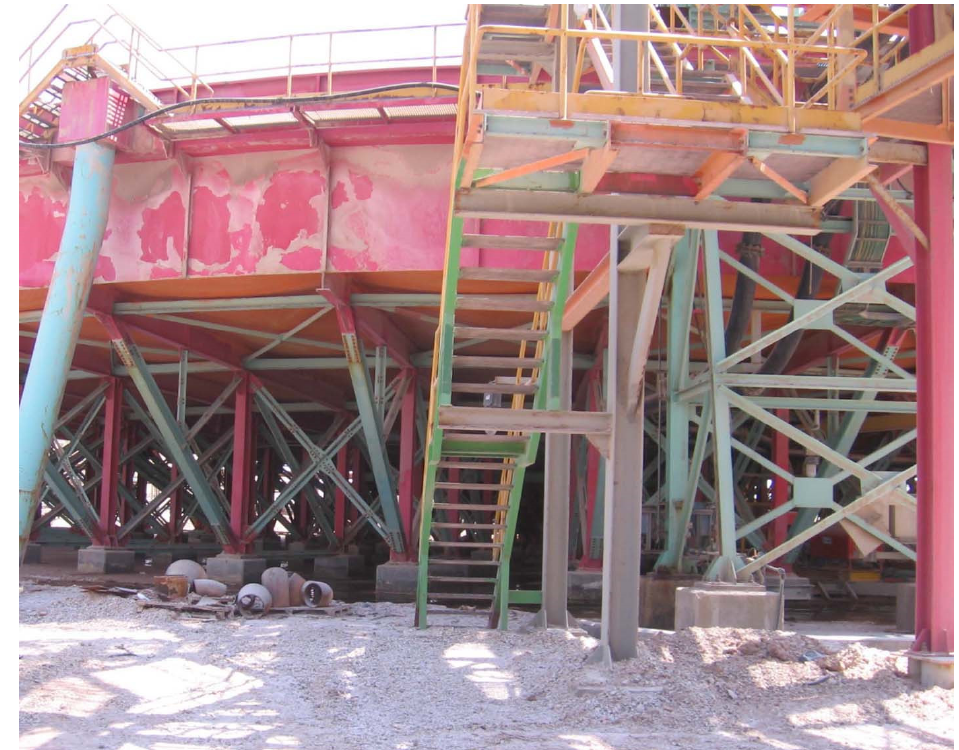
Figure 1. An example of a heavy industrial facility in the sinkhole hazardous zone.